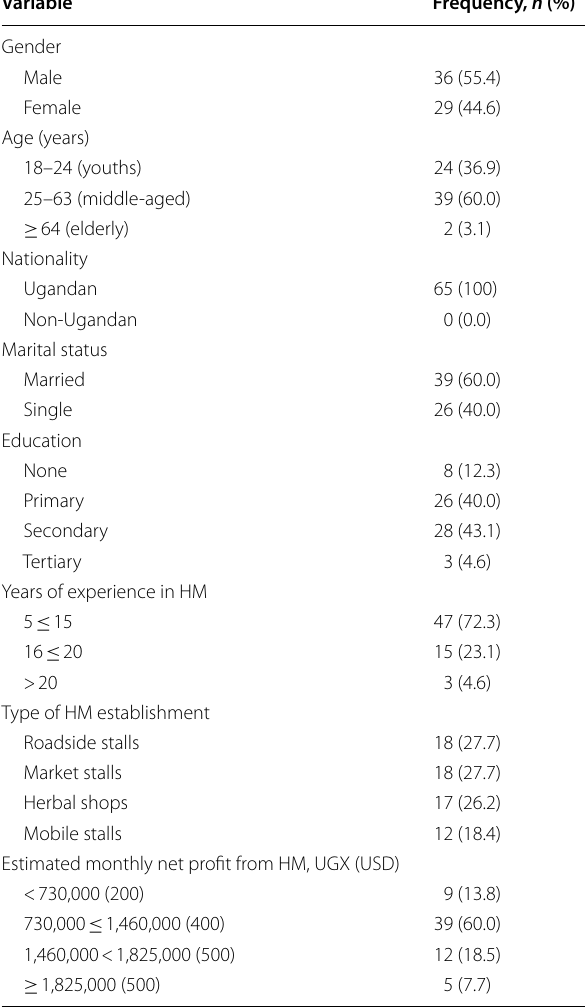
Table 1 Socio-demographic characteristics of